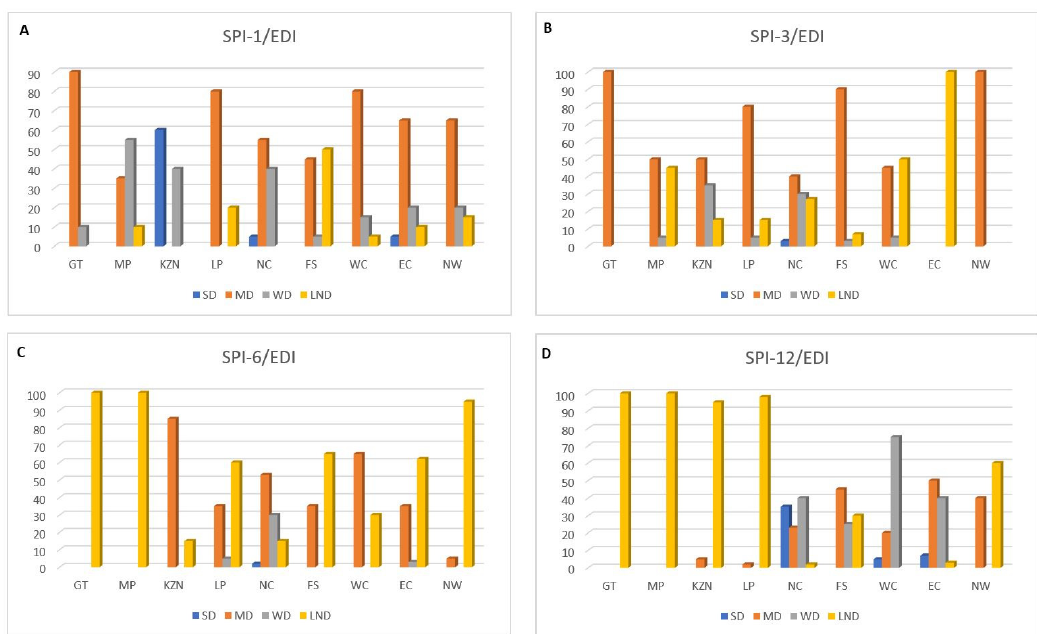
Figure 6. Percentage of Pearson’s correlation coefficient estimate dissimilarity measure for drought severity in South Africa. ( A ) SPI-1/EDI; ( B ) SPI-3/EDI; ( C ) SPI-6/EDI; and ( D ) SPI-12/EDI. Strong Dissimilarity (SD), Moderate Dissimilarity (MD), Weak Dissimilarity (WD), Little or No Dissimilarity (LND).